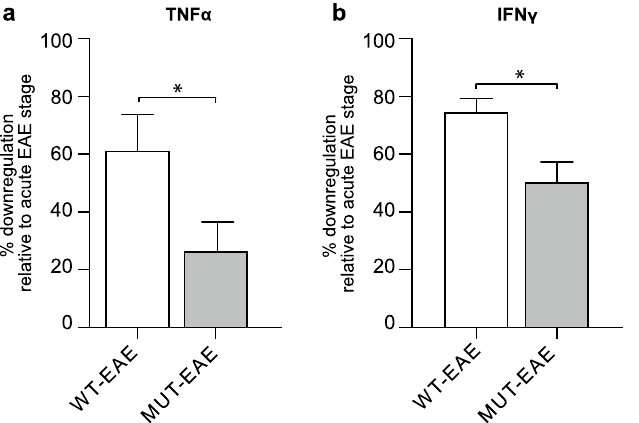
Figure 5. Downregulation of TNFα and IFNγ levels in chronic EAE. TNFα and IFNγ concentrations secreted by MOG-stimulated cells isolated from the acute phase were considered 100%. Using the concentrations secreted by MOG-stimulated cells isolated from the chronic phase, we calculated the percentage of TNFα and IFNγ levels secreted, relative to the acute phase. Data represents the percentage of downregulation, calculated as the difference between 100 and the relative percentage obtained at chronic phase per animal (mean ± SEM). Results were analyzed using an unpaired t-Student test. *p < 0.05. WT-EAE n = 4; MUT-EAE n =